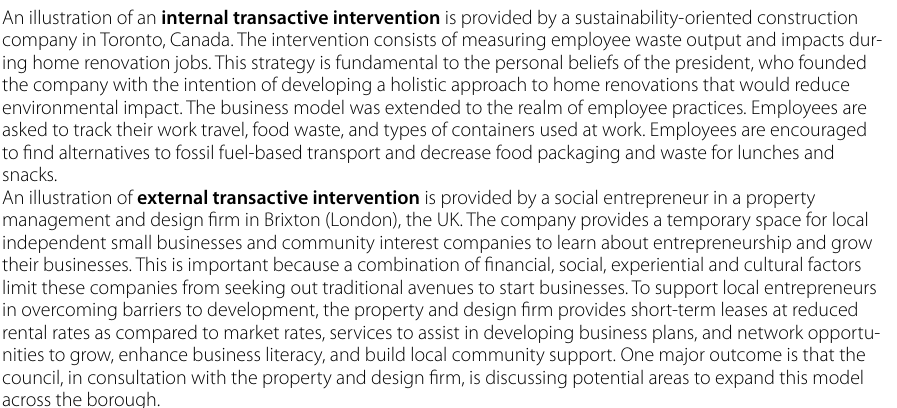
Table 3 Illustrative examples of transactive